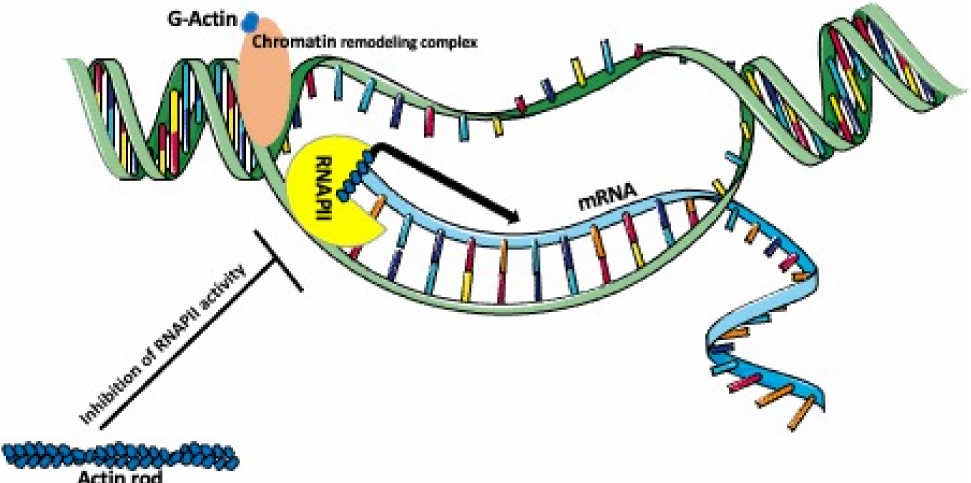
Figure 3. Actin’s role in chromatin remodeling and transcription. Nuclear G-actin, as a part of a chromatin remodeling complex, participates in remodeling a condensed transcriptionally inactive heterochromatin into the RNA polymerase accessible decondensed euchromatin. Monomeric or oligomeric actin forms a complex with RNAPII promoting the enrichment of RNPII at the promoter and the transcription of mRNA. In contrast, nuclear actin rods, which are formed during the stress, inhibit the actin-dependent activity of